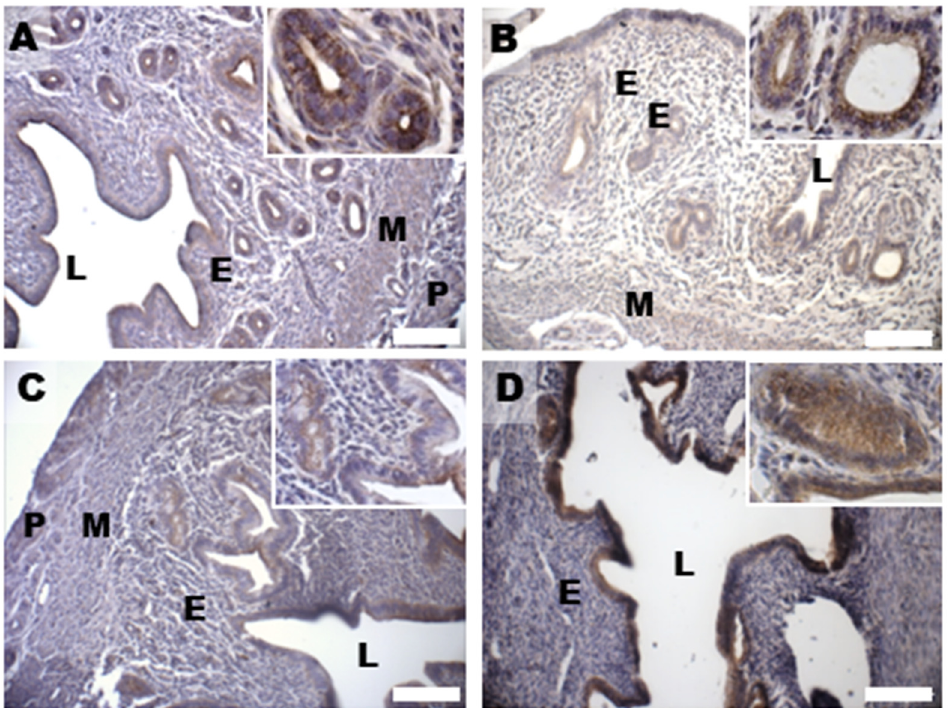
Figure 9. Immunostaining of mouse uterine horns for TOMM20 ( A – D ) of control ( A ), DHEA ( B ), DHEA/LC-ALC ( C ) and DHEA/LC-ALC-PLC ( D ) groups. Insets show details of the glandular epithelium. L: lumen; E: endometrium; M: myometrium; P: perimetrium. LM, mag. 10 × . Insets: 20 × .